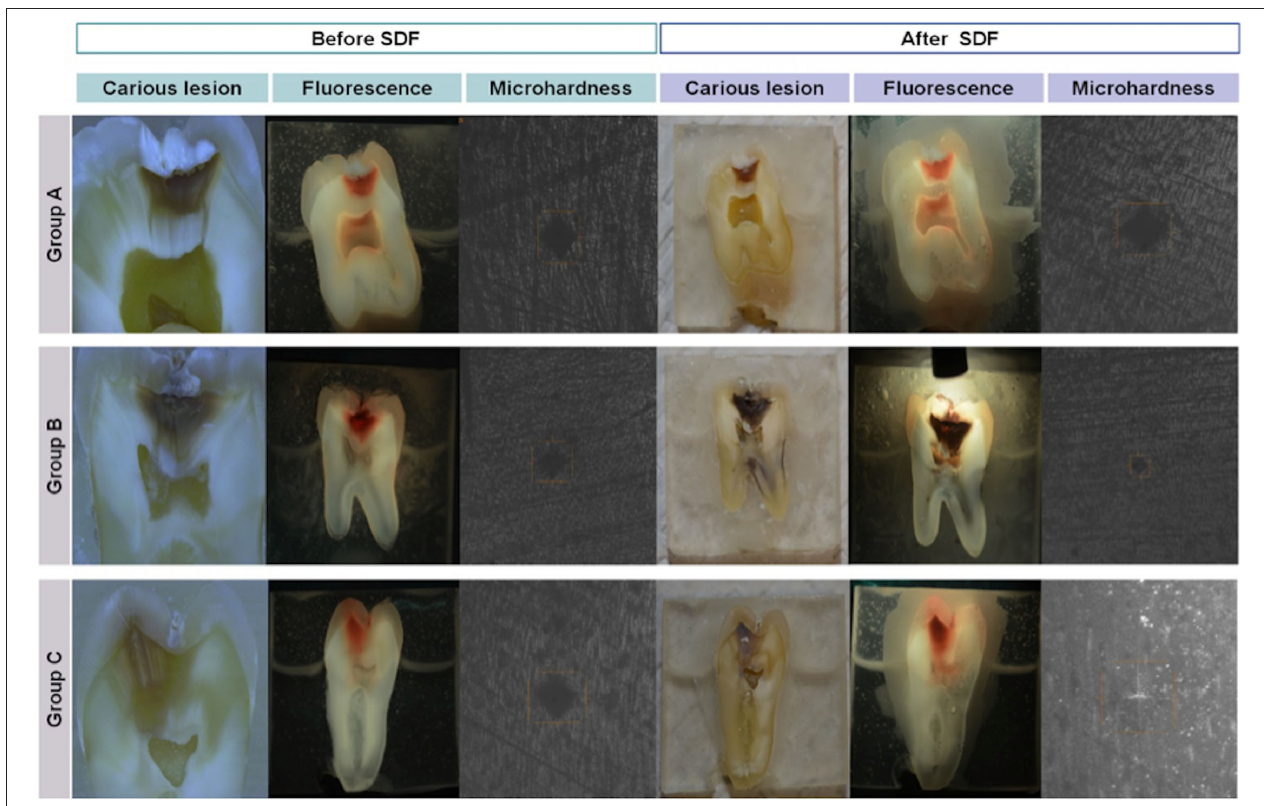
FIGURE 4 | Carious lesions, fluorescence, and microhardness indents recorded before and after SDF in all